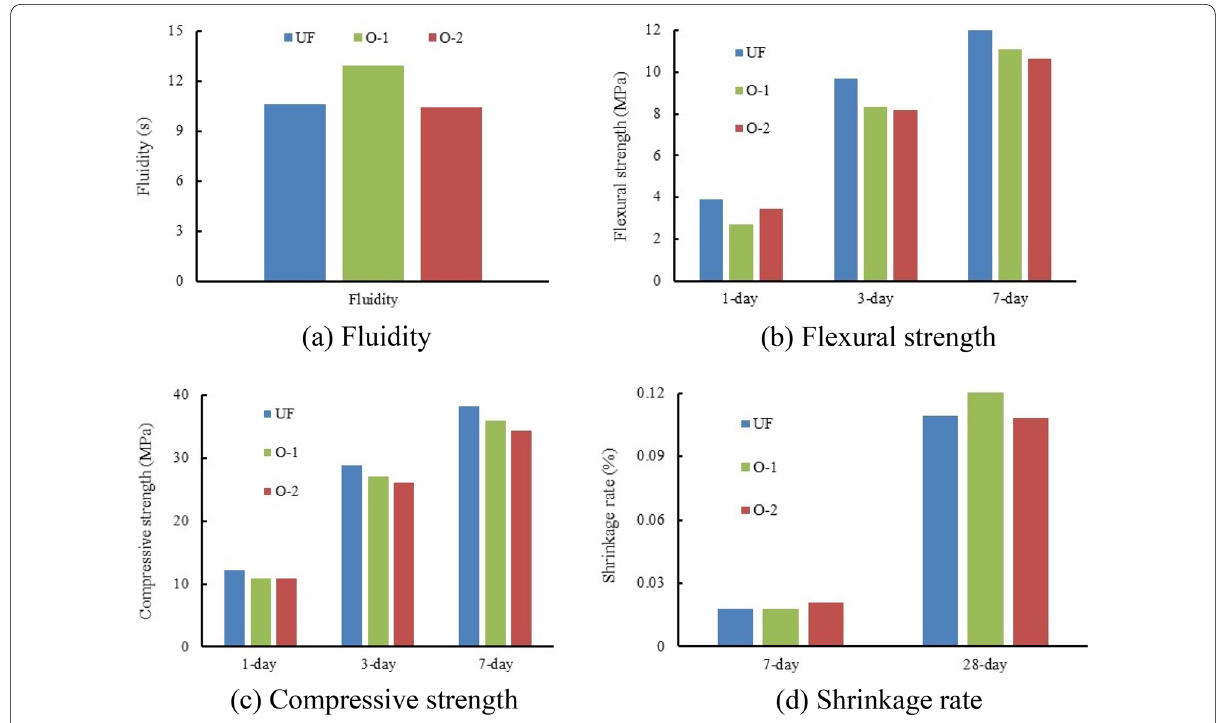
Fig. 9 Engineering properties of different